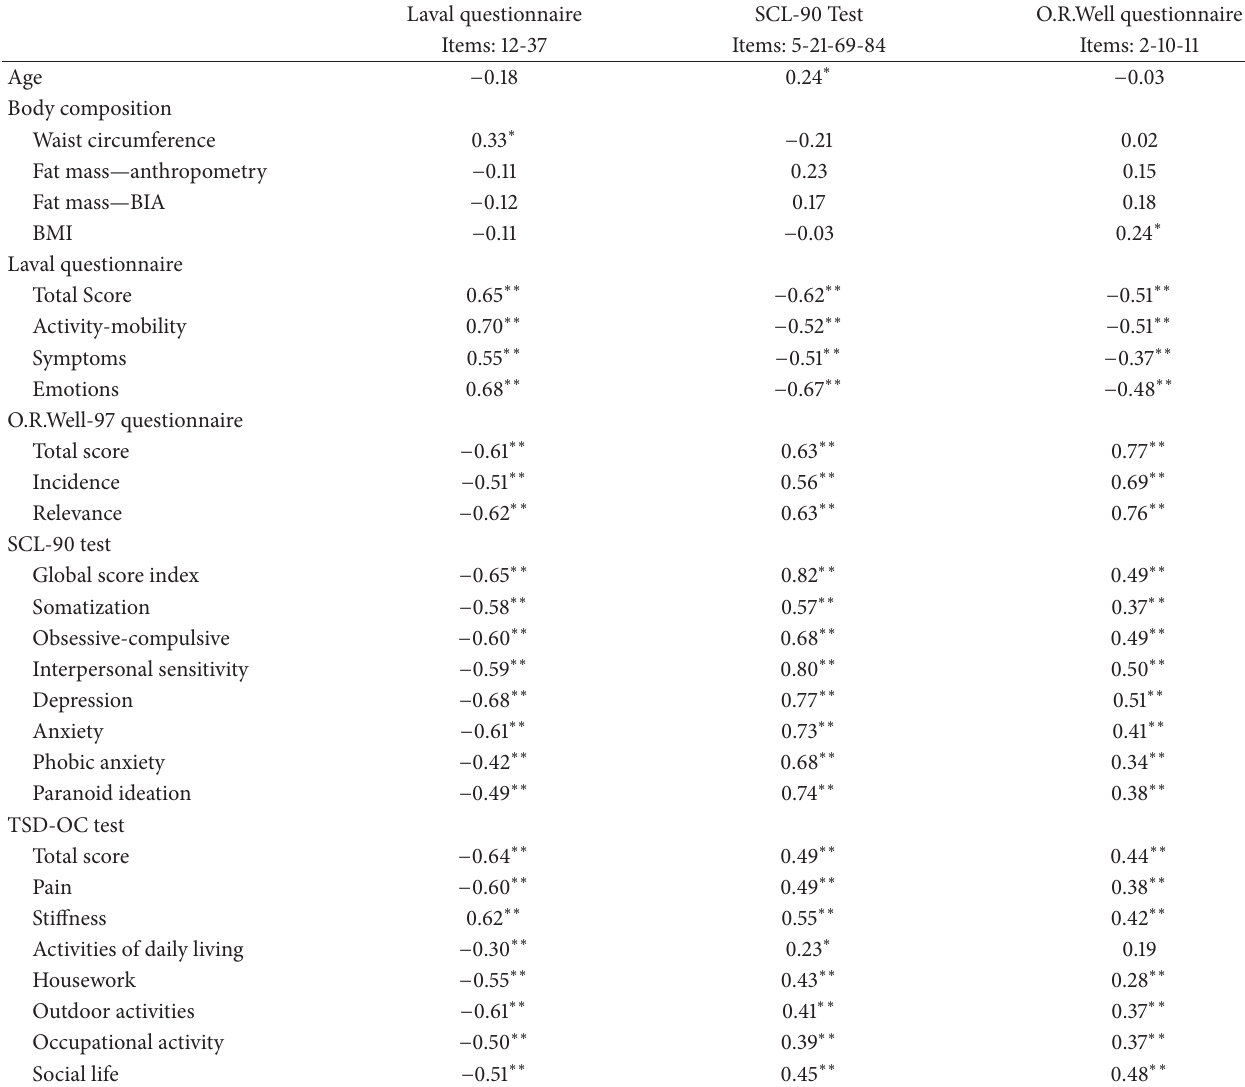
Table 2: Correlations between sexual life domain (at Laval questionnaire, SCL-90 test, and O.R.WELL questionnaire) and quality of life, psychological status, and